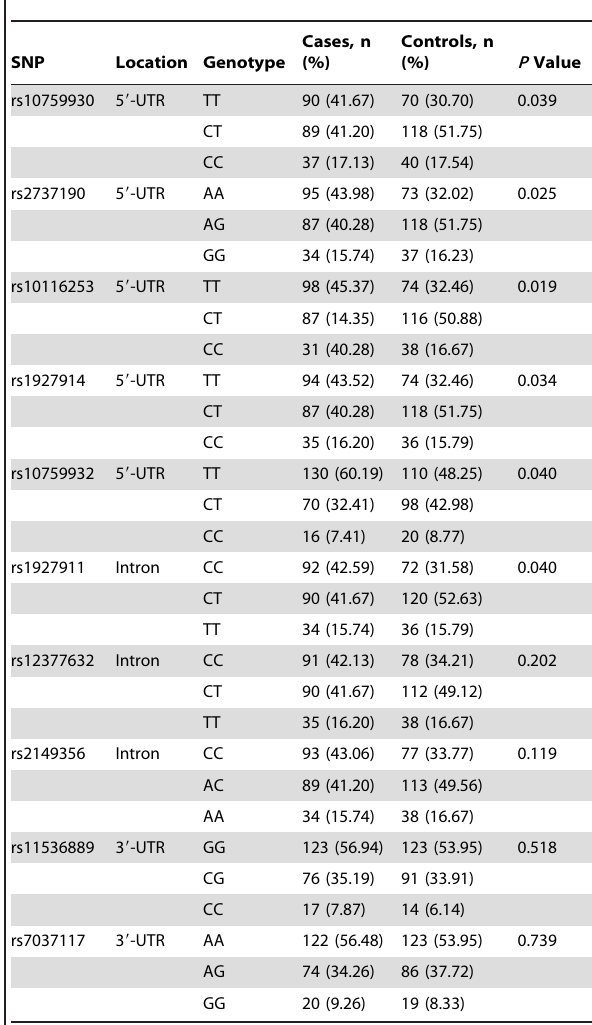
Table 2. Genotype frequencies of TLR4 single nucleotide